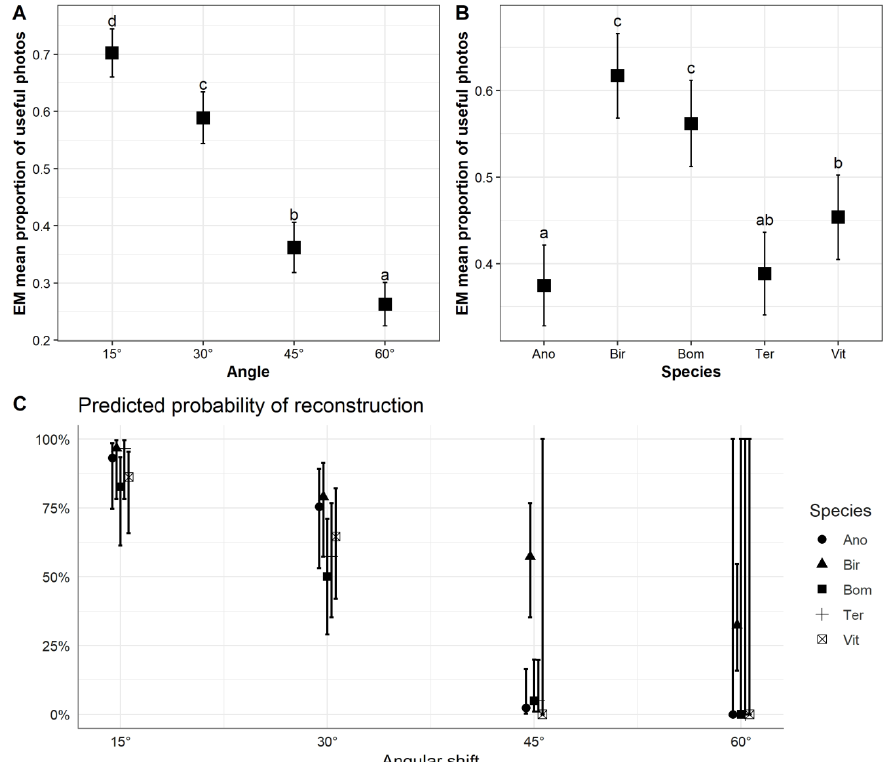
Figure 6. Proportion of useful images in relation to angular shift ( A ) and species ( B ). Predicted probability of the reconstruction of species-specific 3-D models is also shown in relation to angular shift ( C ). Ano: Anogeissus leiocarpa ; Bom: Bombax costatum ; Bir: Sclerocarya birrea ; Ter: Terminalia laxiflora ; Vit: Vitellaria paradoxa. Means with di ff erent letters (a, b, c and d) are statistically di ff erent (Waller-Duncan test, p <